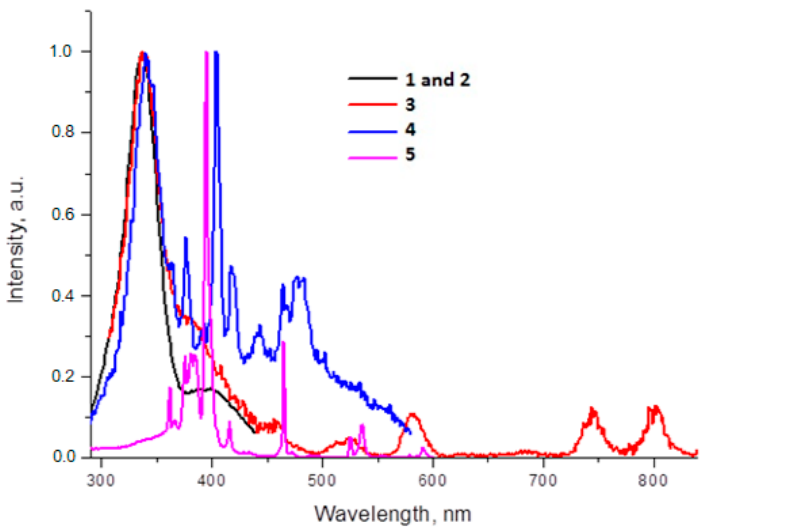
Figure 9. Excitation spectra of complexes registered for most intensive emission line ((1/2)- λ em =